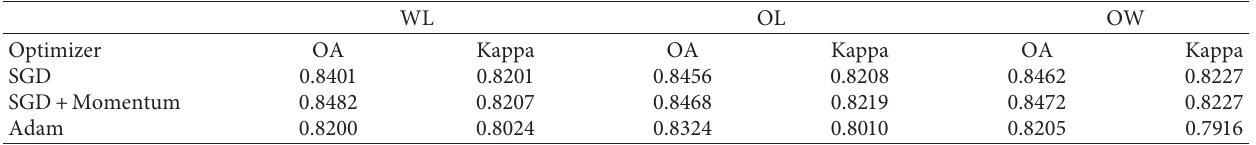
Table 5: Accuracy comparison of different optimizers.